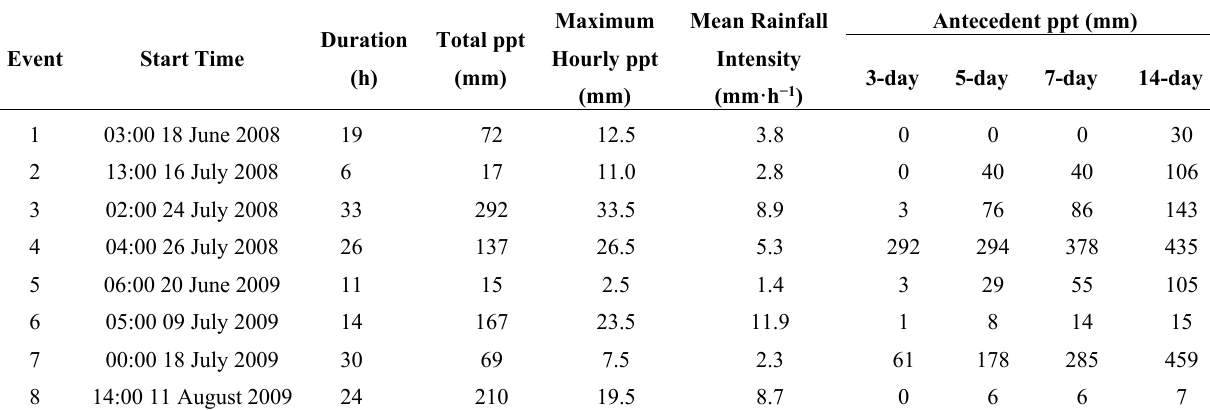
Table 3. Summary of hydroclimatic conditions that characterize the eight described rainfall events. Ppt indicates